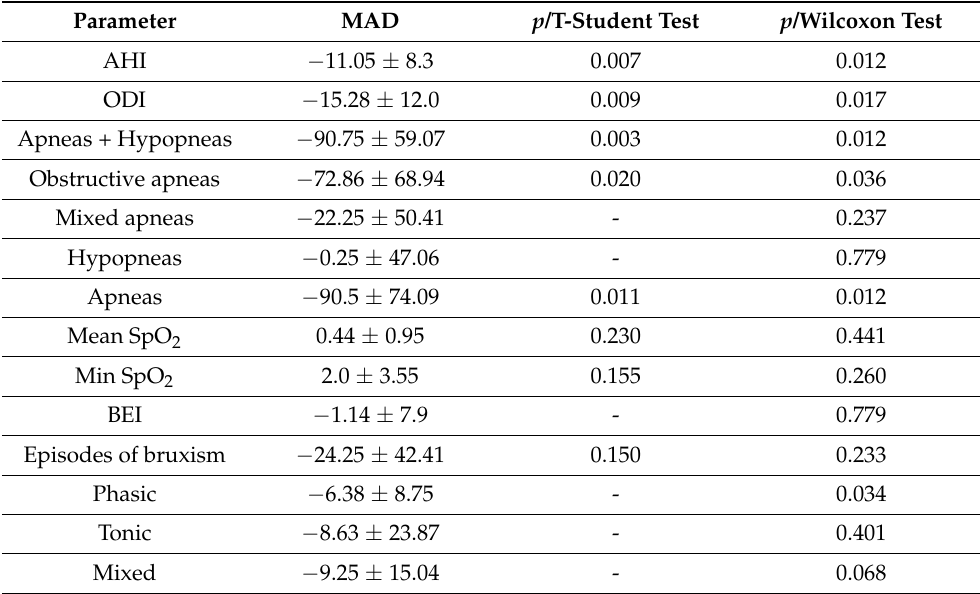
Table 3. Mean changes of the values of the parameters assessed with polysomnographic examinations following MAD